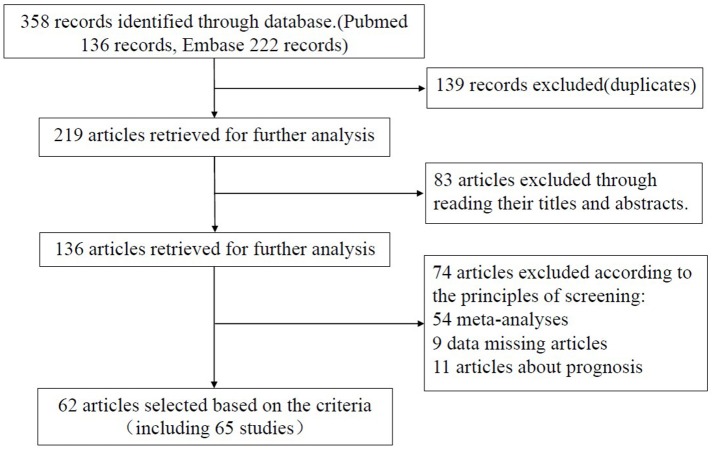
Flow chart of the study selection process.